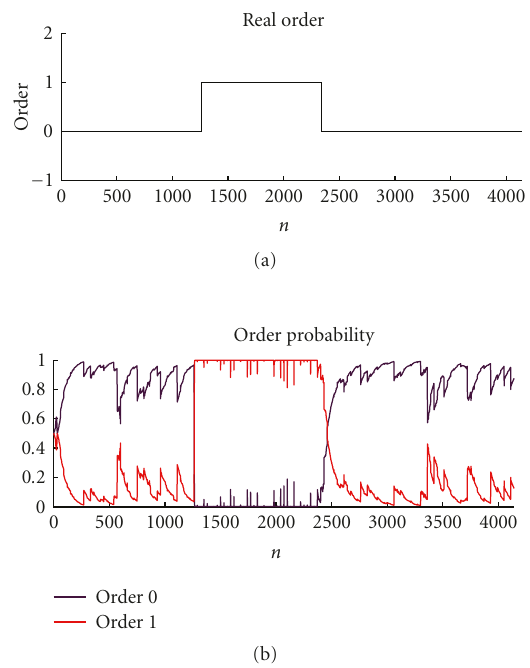
Figure 9: The order probability evaluation for orders 0 and 1.